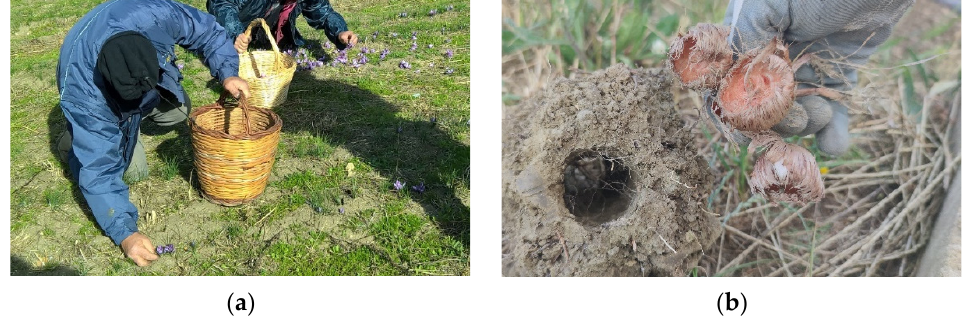
Figure 7. Some critical aspects of Crocus sativus L. crop: kneeling workers during harvest ( a ); residues of saffron corms eaten by voles in ground soil in a Tricarico open field ( b ). The captured, detected and elaborated data, relative to the three trial years, concerned ature, daily rainfall) in the two experimental areas (Picerno and Tricarico), flower